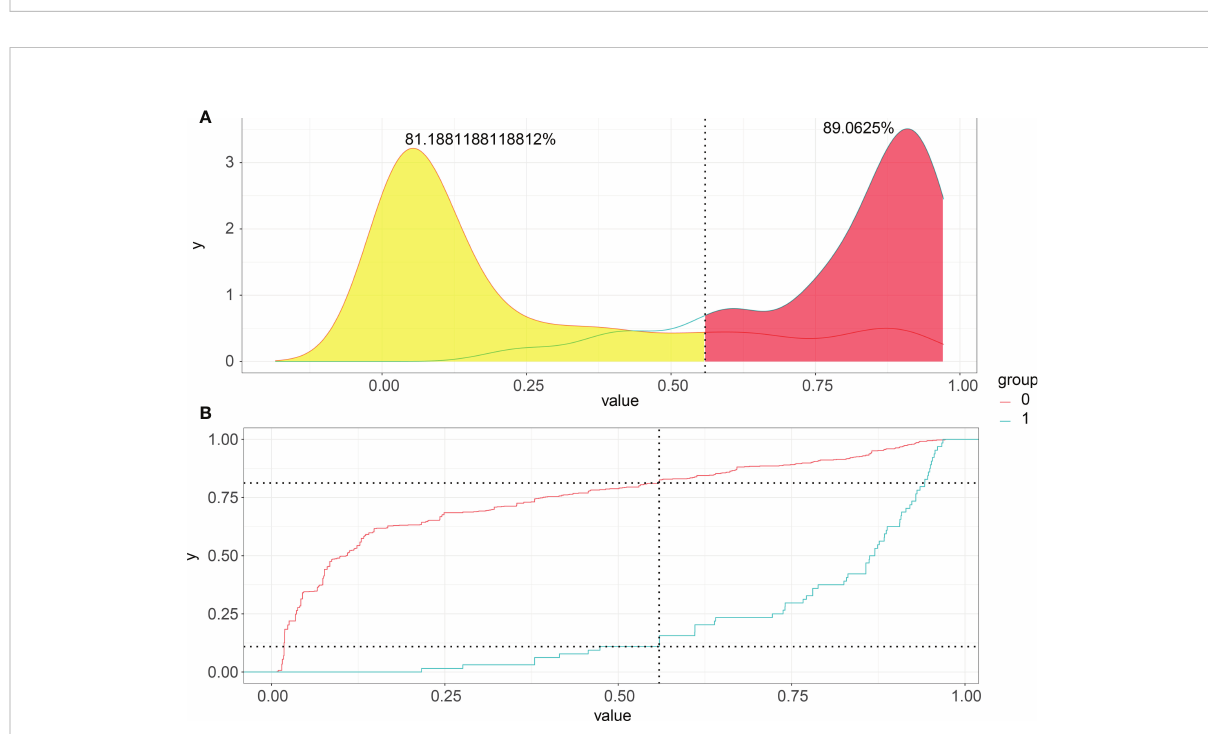
FIGURE 5 Probability density functions and Clinical utility curves of the predictive model. (A) Non-LNM patients were mostly concentrated in the portion representing 0-54.6% LNM risk, and LNM were distributed in the residual section; (B) The true positive percentage of LNM and non-LNM at any threshold of